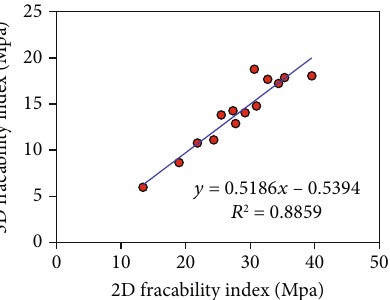
Figure 9: Comparison between the 2D core fracability index and the 3D core fracability